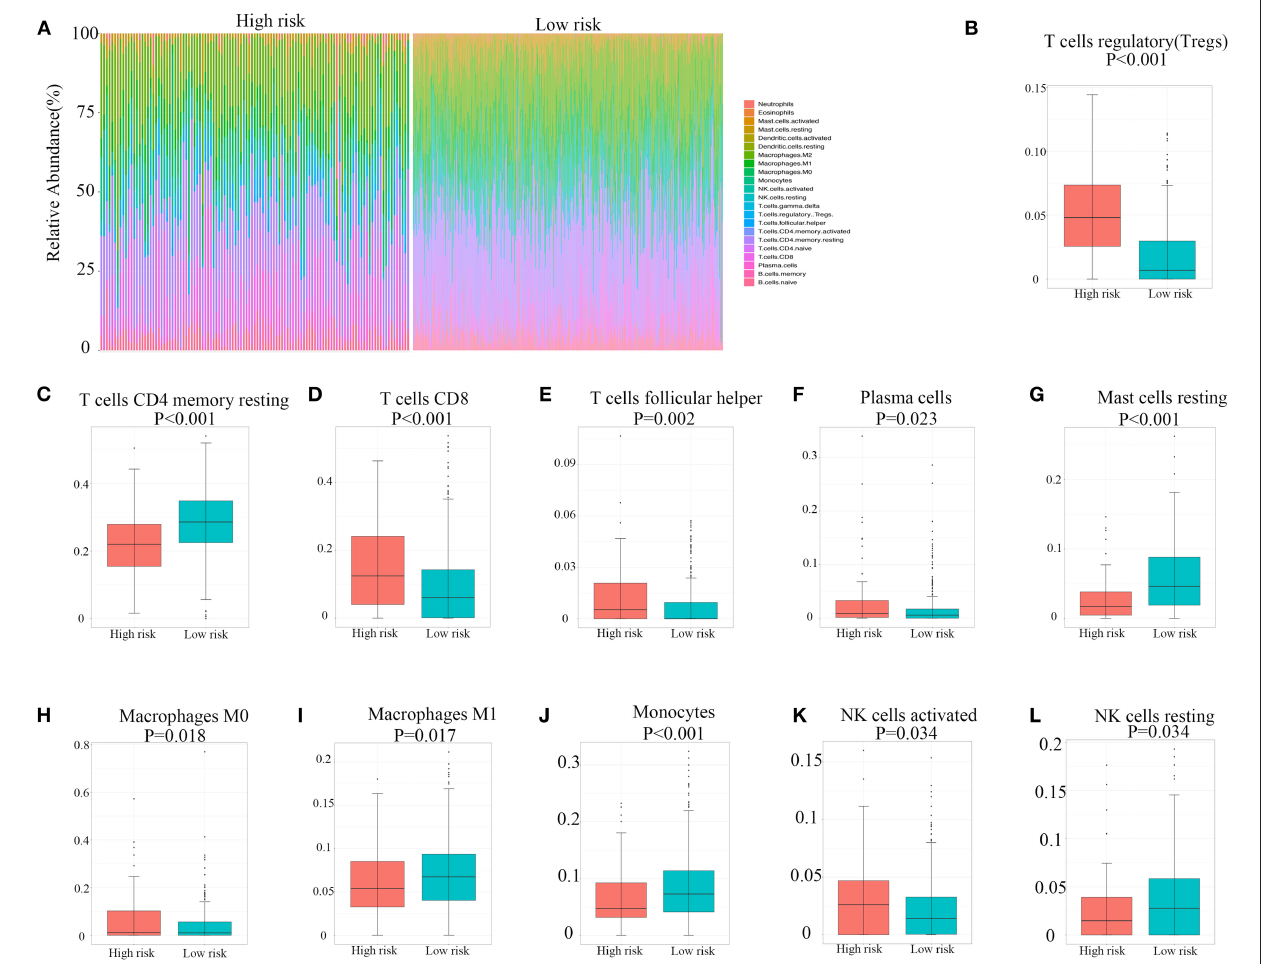
FIGURE 4 | Immune landscape between high and low hypoxia risk score groups of renal cell carcinoma patients. (A) The abundance of immune infiltration in high-risk and low-risk groups from TCGA cohort. (B–L) The proportions of different immune cells between high-risk and low-risk groups in TCGA cohort. TCGA, The Cancer Genome